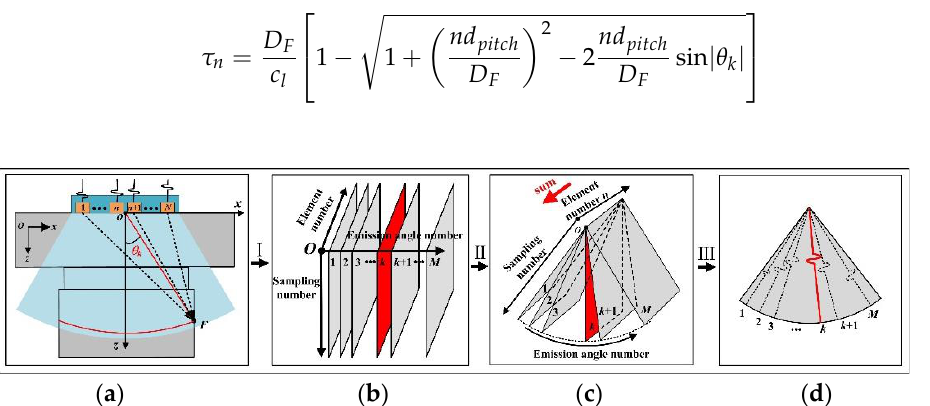
Figure 1. Schematic diagram of phased array sector scan beam−forming process. ( a ) Beam steering and focusing, ( b ) signal acquisition, ( c ) coordinate transformation, and ( d ) sector scanning imaging display.